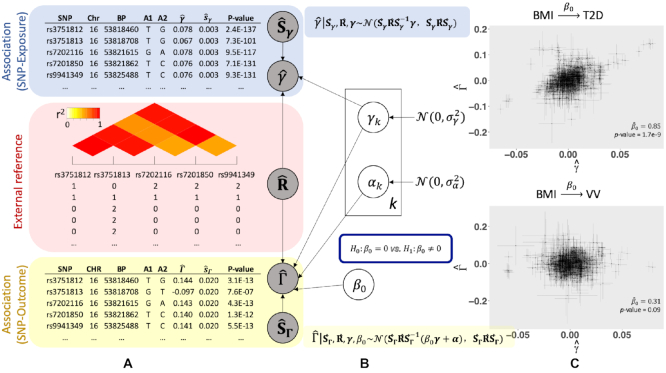
MR-LDP model overview. (A) Inputs for MR-LDP include GWAS summary statistics from both the risk factor (blue) and the disease outcome (yellow), and an external reference panel data (red). (B) A probabilistic graphical model representation of MR-LDP. The box is the ‘plate’ representing SNPs, k = 1, …, p. The circles are either variables or parameters. The circle outside the block is the primary parameter of interest. The variables in shaded circles are observed (i.e. GWAS summary statistics \documentclass[12pt]{minimal}
\usepackage{amsmath}
\usepackage{wasysym} 
\usepackage{amsfonts} 
\usepackage{amssymb} 
\usepackage{amsbsy}
\usepackage{upgreek}
\usepackage{mathrsfs}
\setlength{\oddsidemargin}{-69pt}
\begin{document}
}{}$\lbrace \widehat{\gamma }_k, \widehat{{\mathbf {s}}}_{\gamma _k} \rbrace _{k = 1, \ldots , p}$\end{document} and \documentclass[12pt]{minimal}
\usepackage{amsmath}
\usepackage{wasysym} 
\usepackage{amsfonts} 
\usepackage{amssymb} 
\usepackage{amsbsy}
\usepackage{upgreek}
\usepackage{mathrsfs}
\setlength{\oddsidemargin}{-69pt}
\begin{document}
}{}$\lbrace \widehat{\Gamma }_k, \widehat{{\mathbf {s}}}_{\Gamma _k} \rbrace _{k = 1, \ldots , p}$\end{document}, and the estimated \documentclass[12pt]{minimal}
\usepackage{amsmath}
\usepackage{wasysym} 
\usepackage{amsfonts} 
\usepackage{amssymb} 
\usepackage{amsbsy}
\usepackage{upgreek}
\usepackage{mathrsfs}
\setlength{\oddsidemargin}{-69pt}
\begin{document}
}{}$\widehat{{\mathbf {R}}}$\end{document} for these p SNPs from a reference panel) and variables in unshaded circles are latent variables (i.e. γk and αk, k = 1, …, p). The primary goal is to conduct a formal hypothesis testing for \documentclass[12pt]{minimal}
\usepackage{amsmath}
\usepackage{wasysym} 
\usepackage{amsfonts} 
\usepackage{amssymb} 
\usepackage{amsbsy}
\usepackage{upgreek}
\usepackage{mathrsfs}
\setlength{\oddsidemargin}{-69pt}
\begin{document}
}{}$\mathcal {H}_0: \beta _0=0\; \mathrm{versus}\; \mathcal {H}_1: \beta _0\ne 0$\end{document}. (C) Scatter plots of effect sizes with their standard errors for two exposure–outcome pairs: BMI-T2D and BMI-VV; T2D for type 2 diabetes and VV for varicose veins. Dots represent the effect sizes from SNP exposure against these from SNP outcome, and horizontal and vertical bars represent the standard errors from SNP exposure and SNP outcome, respectively. The estimated β0 and their P-values from MR-LDP are shown in each part.